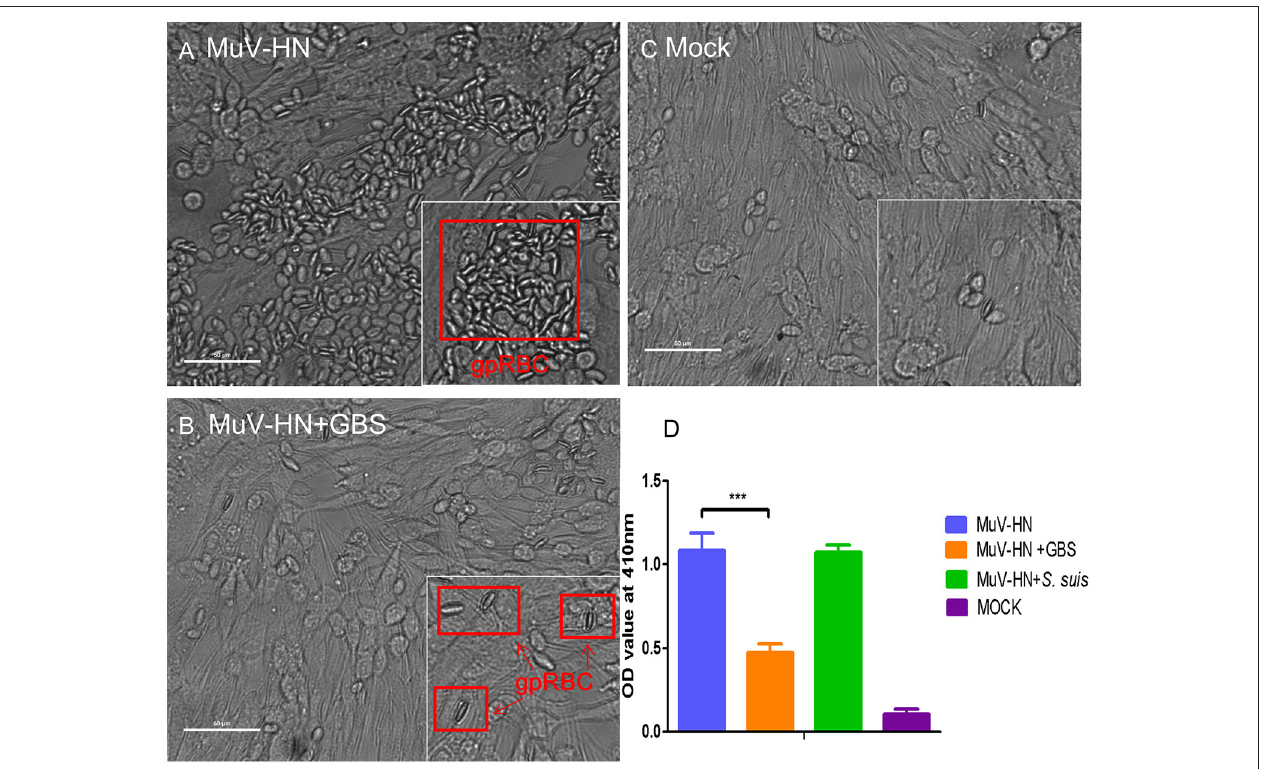
FIGURE 6 | Hemadsorption of MuV-HN. HEp-2 cells were transfected for the expression of MuV-HN. At 24h p.t., cells were incubated with or without streptococci (GBS or S. suis ) for 30min followed by 15min incubation with 2% guinea pig red blood cells (gpRBC) at 4 ◦ C. Adhering red blood cells are highlighted by red boxes in (A) and (B) . Untransfected control cells (expressing no MuV-HN protein, designated “mock”) are shown in (C) . Adhering erythrocytes were lysed and the OD values of the supernatants at 410nm were measured for evaluating the amount of hemoglobin in (D) . As S. suis had no inhibitory effect on the hemadsorption activity of MuV-HN, the result is shown only in the bar chart (D) . All experiments were repeated at least three times with duplicate samples. Statistical analysis was performed with unpaired Student’s t -test, *** P < 0.001 . Scale bars in (A) , (B) , and (C) represent 50 µ